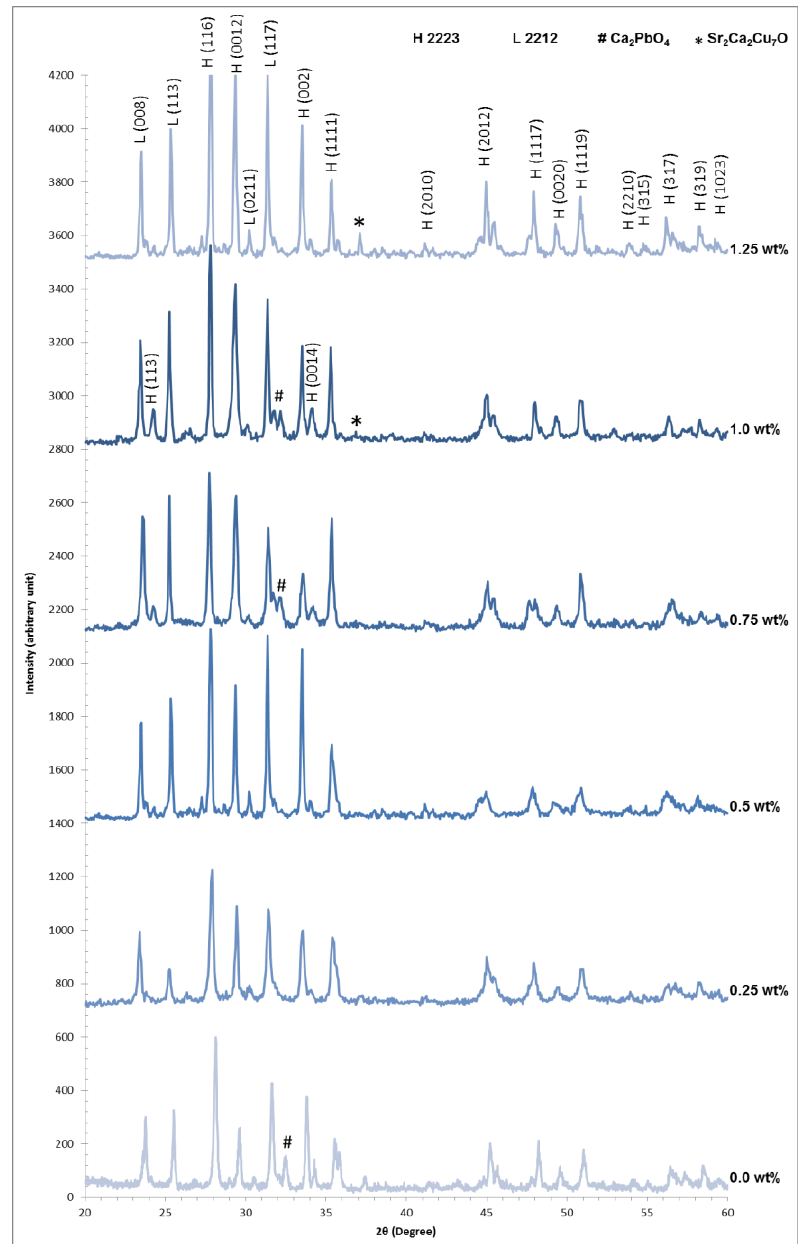
Bi Pb Sr Ca Cu O , where x = (0, 0.25, 0.5, x 1.6 0.4 2 2 3 10+δ Bi Pb Sr Ca Cu O x 1.6 0.4 2 2 3 10+δ